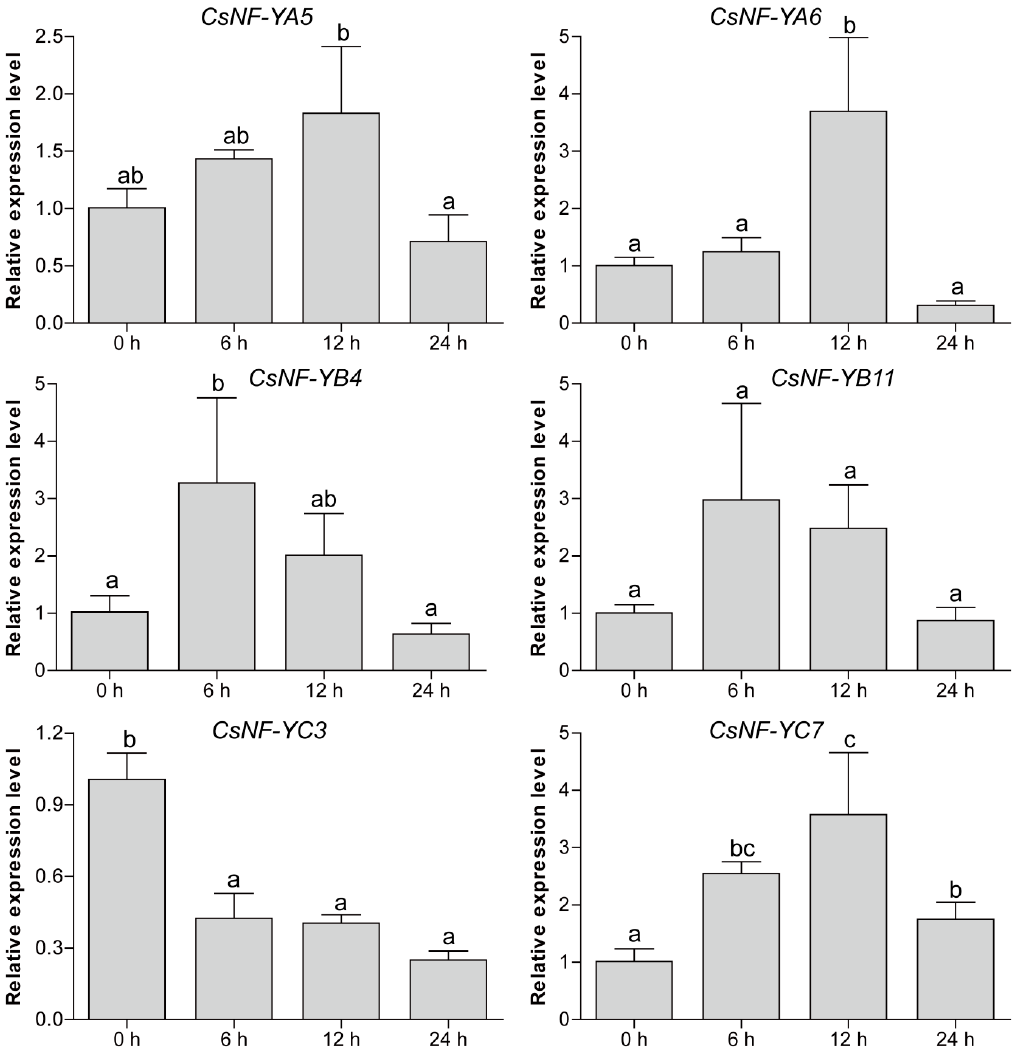
Figure 5. Expression analysis of six selected CsaNF-Y genes in response to drought stress using qRT-PCR. Vertical bars indicate the standard error of the mean, and different letters are significantly different.